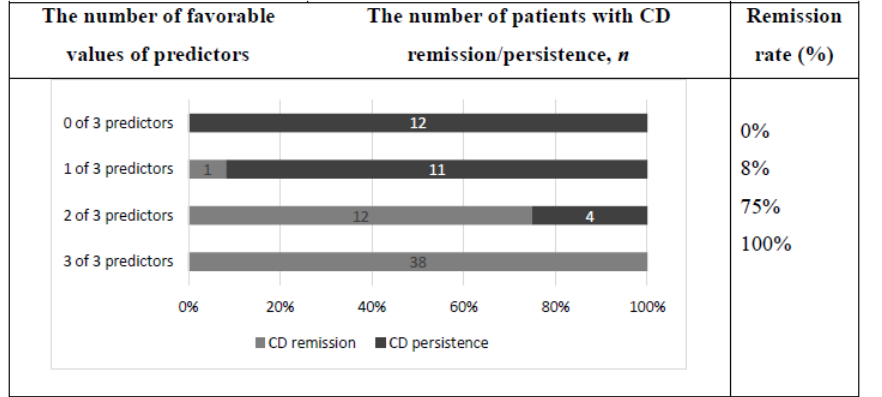
Figure 4. Remission rate one year after TSS depending on the number of favorable values of predictors of CD remission after surgery.